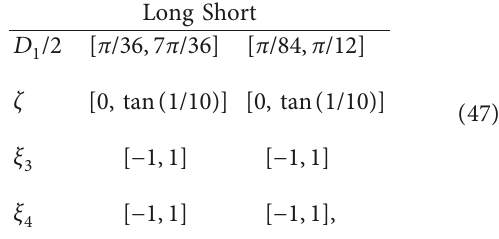
� 2, L , L , and C are deterministic: L 1 1 2 1 is random since it depends on the random slope of the 2